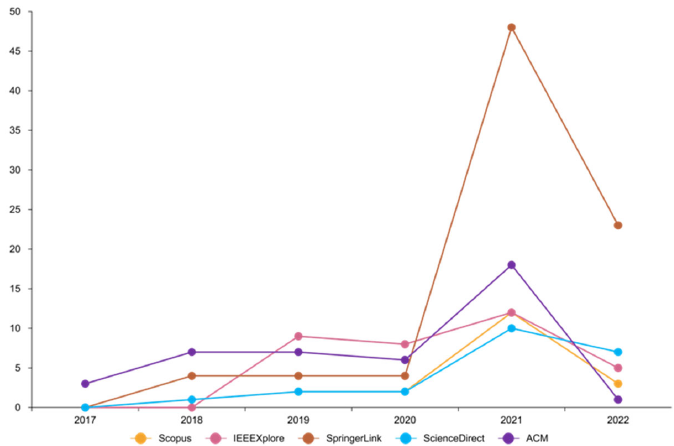
Figure 11. Graph of publications obtained for each queried database per year .